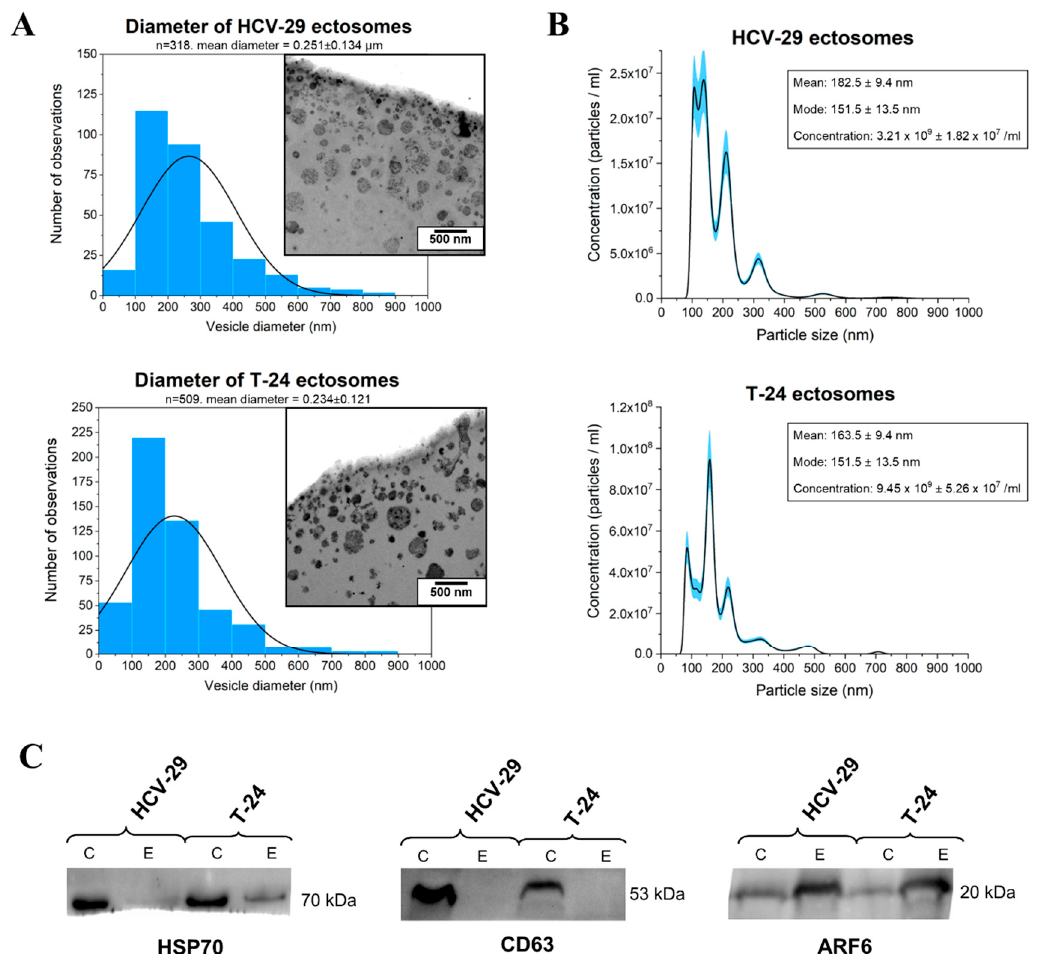
Figure 1. Characterization of ectosome samples isolated from conditioned media of T-24 urothelial bladder carcinoma and HCV-29 normal ureter epithelial cells. ( A ) Morphological characterization of HCV-29- and T-24-derived ectosomes by transmission electron microscopy (TEM). Size distributions are presented on histograms. Mean diameter ± standard deviation was calculated for all observed vesicles ( n ) from a given sample. ( B ) Nanoparticle tracking analysis (NTA) of HCV-29- and T-24-derived ectosomes. Results from five independent measurements for each cell line are presented on graphs. The shaded area depicts standard deviation. ( C ) Representative Western blot of extracellular vesicle markers in whole-cell protein extracts (lines C) and ectosome samples (lines E). Fifty μ g of proteins separated by 10% SDS-PAGE and transferred into PVDF membrane were probed with anti-HSP70 (1:2000), anti-CD63 (1:2000) and anti-ARF6 (1:500) as primary antibodies and anti-mouse IgG-HRP (1:400) as a secondary antibody.